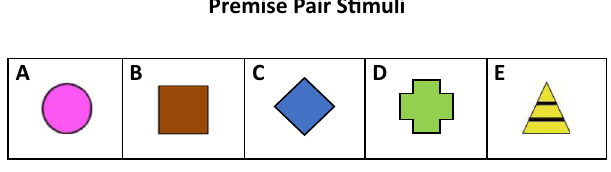
Fig. 2 Training and testing stimuli. Stimuli were of different colours and shapes presented on cards of a uniform background. Stimulus A a pink circle; Stimulus B a brown square; Stimulus C a blue diamond; Stimulus D a green cross and Stimulus E a yellow and black striped triangle. The hierarchical order of stimuli was maintained throughout the experiments such that A > B > C > D